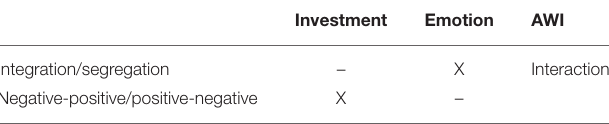
TABLE 5 | Summary of statistical results for BN/SP.